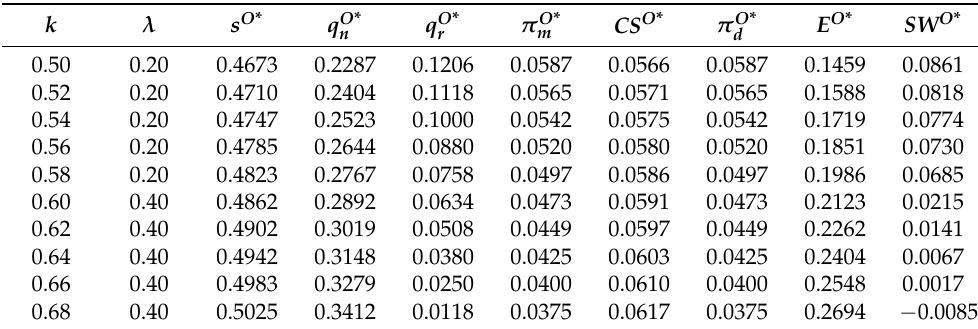
Table 5. The sensitivity analysis results for Model O.